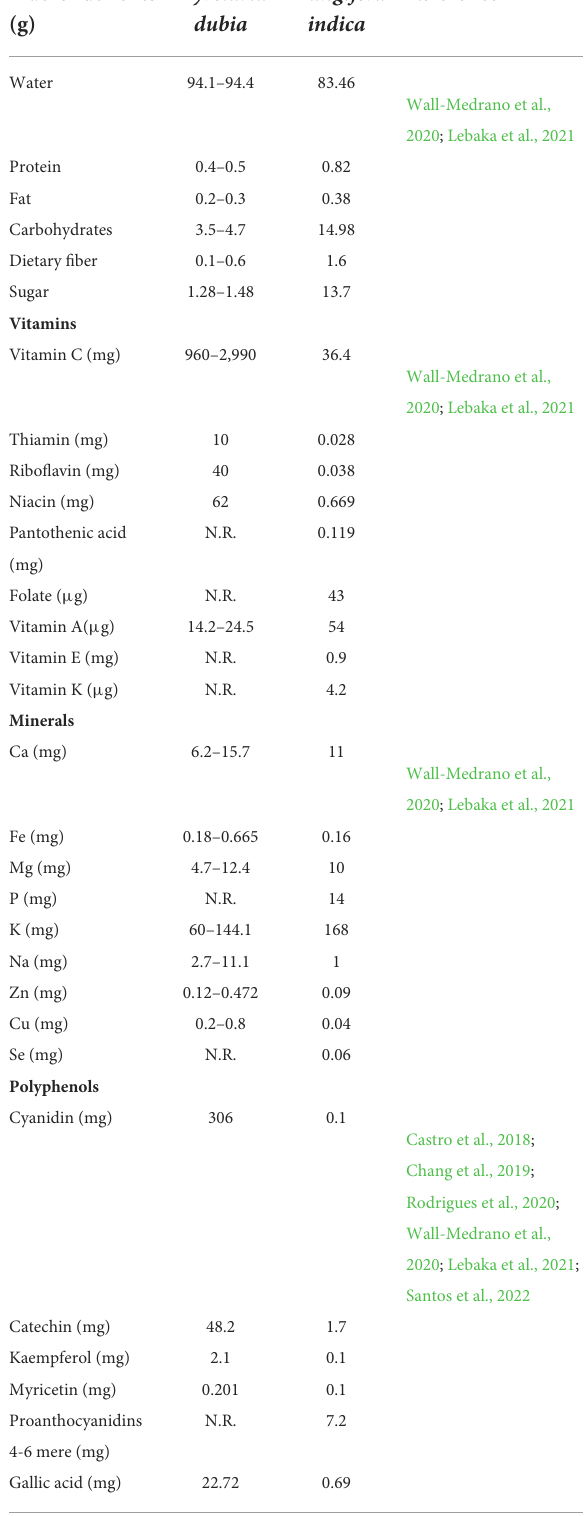
TABLE 1 Nutritional composition per 100 grams of pulp of M. dubia and M. indica